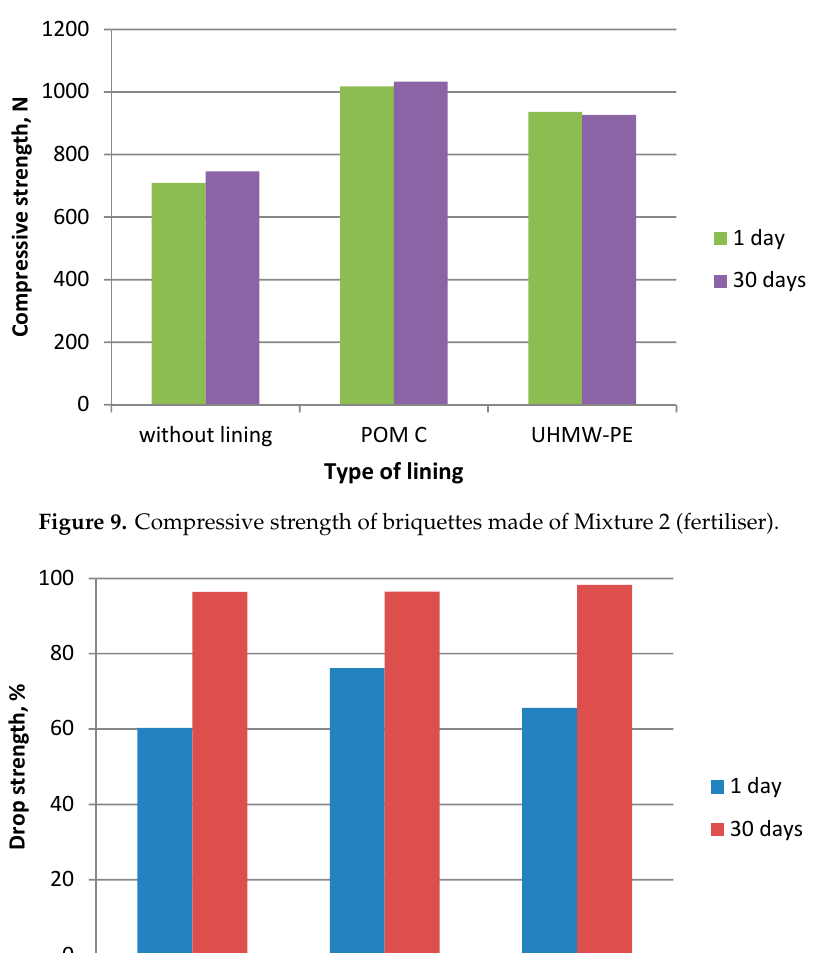
Figure 11. Compressive strength of briquettes made of Mixture 3 (charcoal fines mixed with 4% of starch).